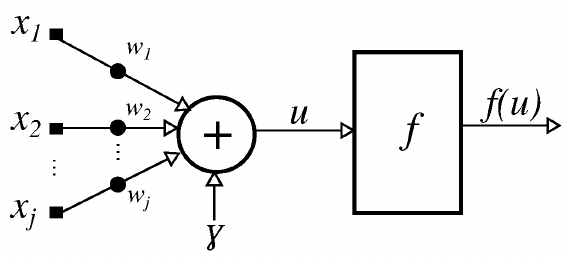
Figure 2. Structure of an artificial neuron, taken from [78].